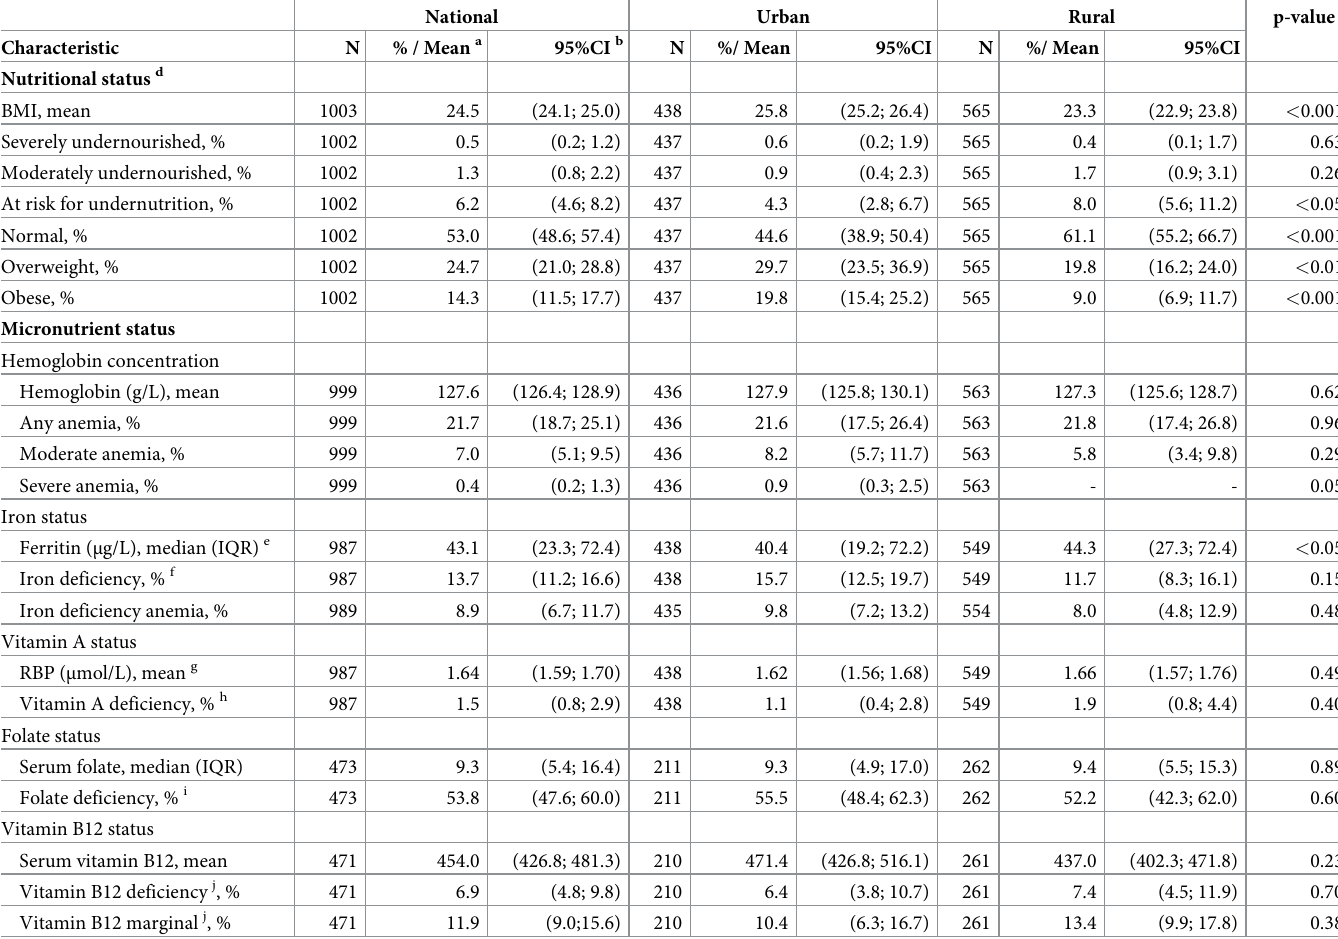
Table 4. Nutritional and micronutrient status among non-pregnant women of reproductive age, Ghana 2017.